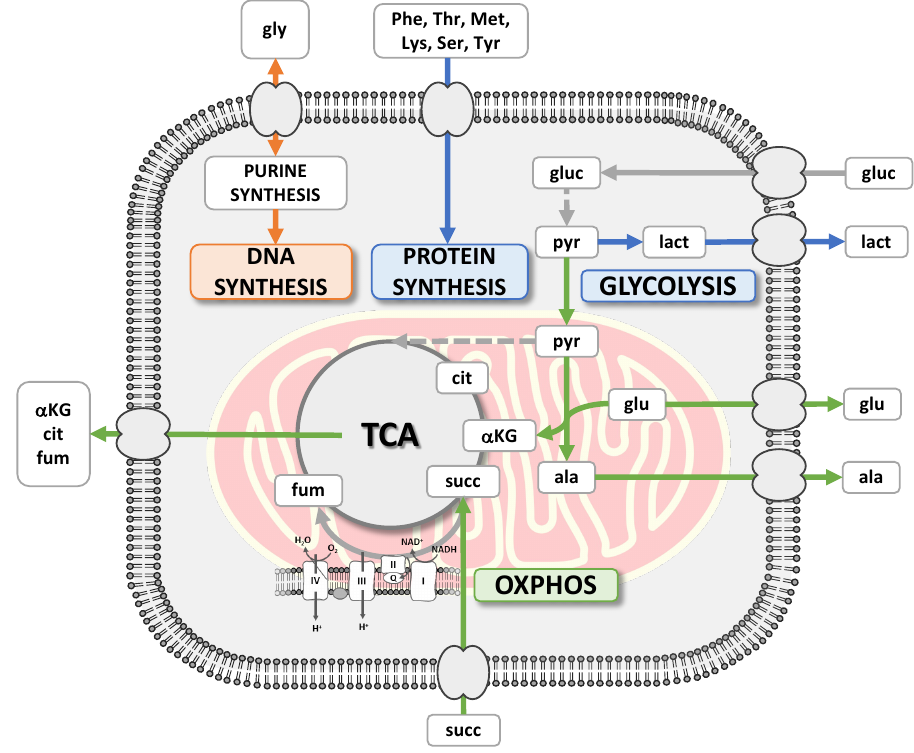
Figure 9. The consumptions and excretions delineate the metabolic routes to produce energy through glycolysis and OXPHOS or to support protein and DNA synthesis. The blue color for glycolysis and protein synthesis indicates their strong